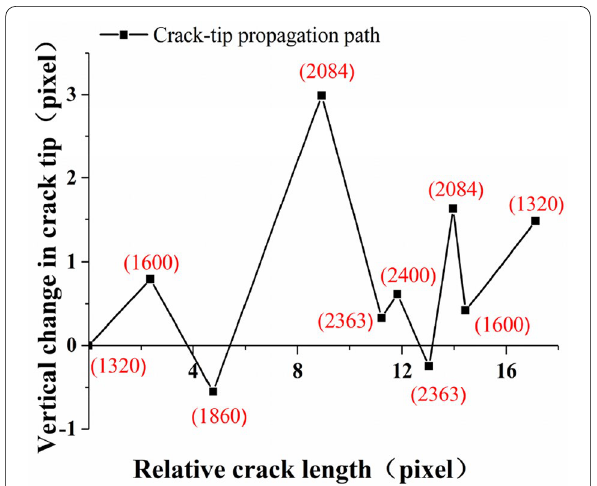
Figure 6 Crack tip position during loading and unloading